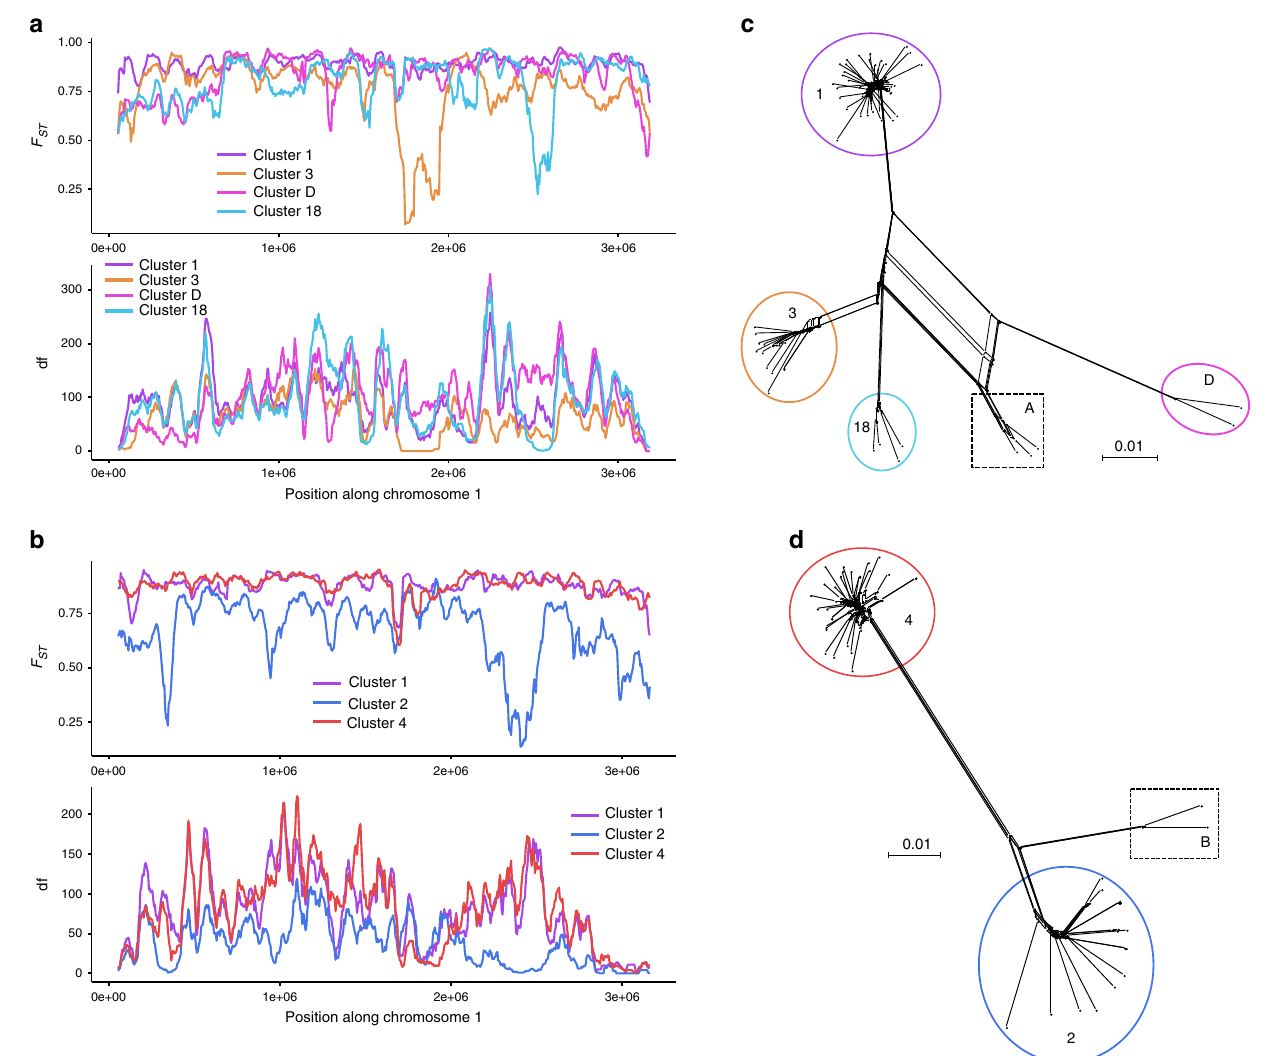
Fig. 4 Evidence of admixture in clusters A and B. a and b Genomic scans of F ST ( fi xation index, an index measuring the differentiation between populations) and df (the number of fi xed differences between populations) in sliding windows of 50 kb using a window step of 5000 bp. Predicted regions of admixture correspond to those that show a drop in both F ST and df. a Comparison of cluster A to clusters 1, 3, D and 18 along chromosome 1; b comparison of cluster B to cluster 1 and 2 along chromosome 1; c , d neighbor-net analyses based on SNP data including c clusters A, 3, D, 18 and 1 and d clusters 2, B and 1; branch lengths are shown in c and d and the scale bar represents 0.01 substitutions per